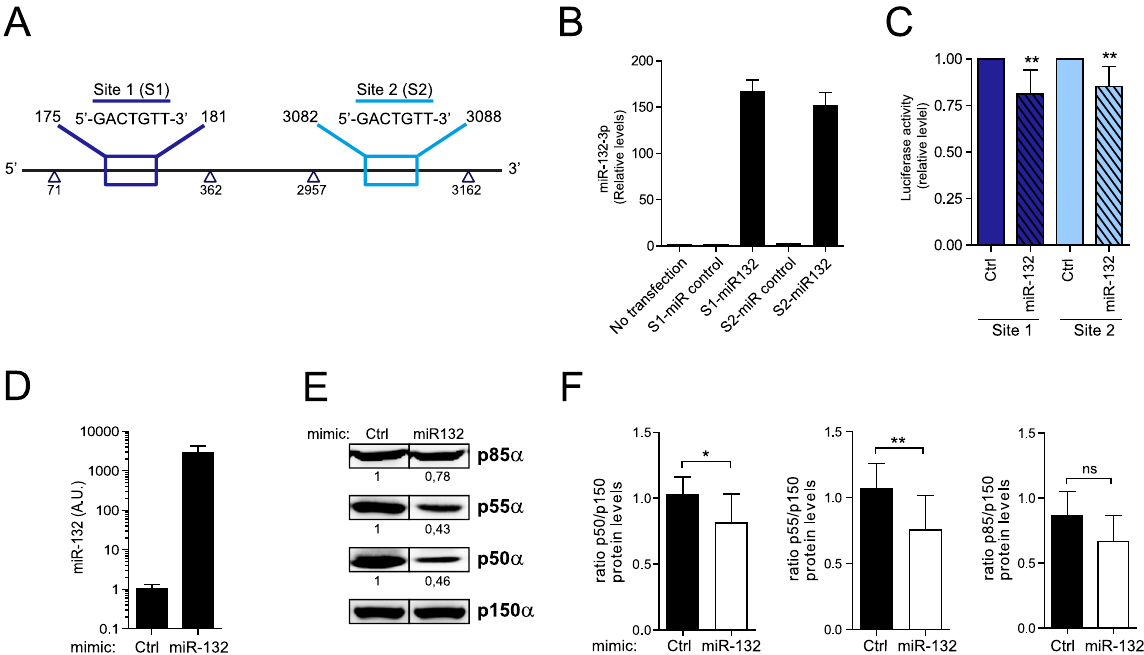
Figure 3. miR-132-3p targets pik3r1. (A) 3 ′ UTR of pik3r1 cloning strategy. Fragments from 71 to 362 bp and from 2957 to 3162 bp containing the two binding sites predicted for miR-132-3p were cloned into the psiCheck2 vector. (B) miR-132-3p levels in HEK cells after transfection. Levels were normalized to RNU1A1 and RNU5G. (C) HEK cells were transfected with indicated plasmids (Control empty vector or miR-132 expressing vector), GFP + cells sorted and Renilla and Firefly luciferase signal measured. Data are presented in Renilla Luciferase signal relative to Firefly (n = 5). T-test ** P < 0.05. (D) miR-132-3p expression in Jurkat cells 48 h post transfection with either negative Control-Dy547 or mmu-miR-132-3p miRNA Mimics. (E) Western blot analysis of p85 α , p55 α and p50 α isoforms in Jurkat cells after 48 h of transfection with the control